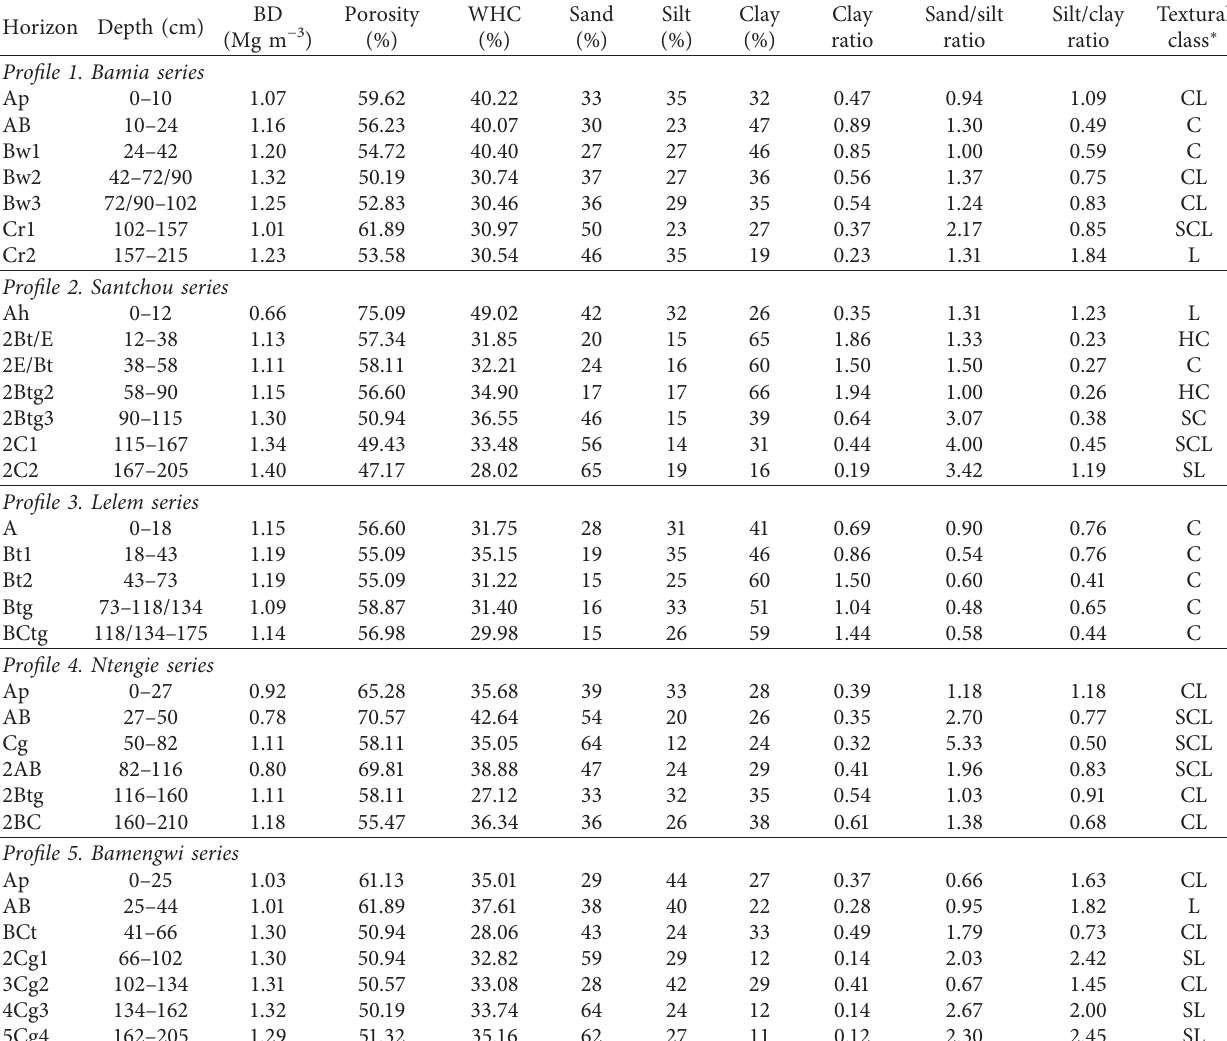
Table 4: Physical properties of the